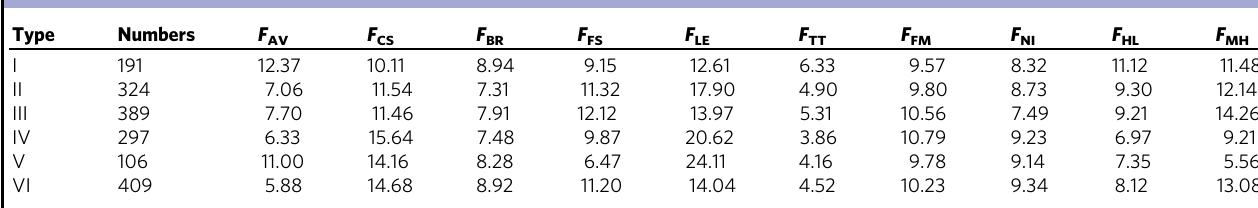
Table 4 Proportions of functions of each PHS structure